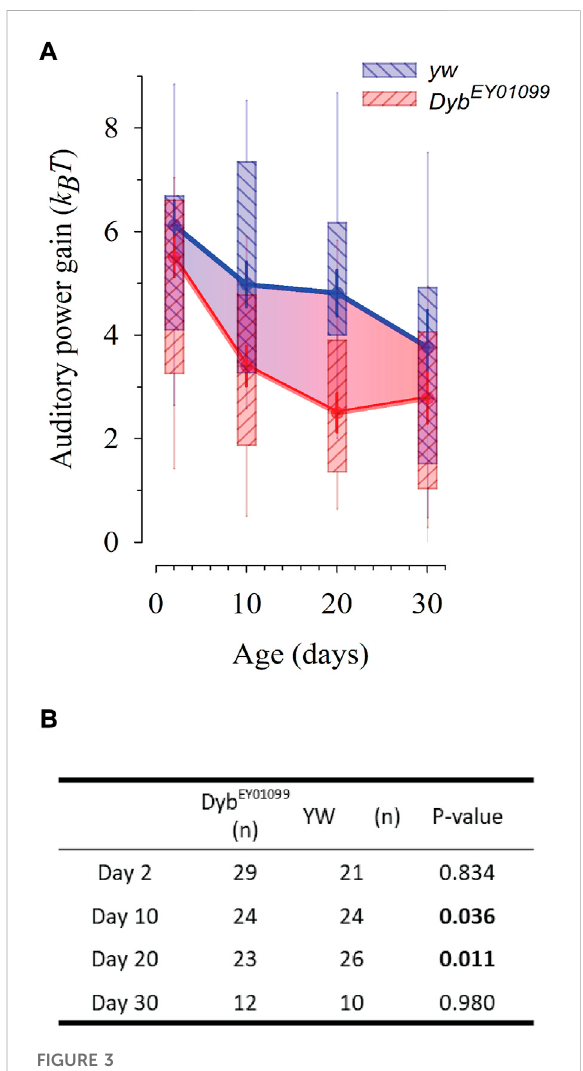
FIGURE 3 Dyb EY01099 mutant fl ies present with progressive, early onset hearing loss. The life course of auditory power gain ( Δ KBT, the fl y ’ s ‘ cochlear ampli fi er ’ ) is affected in Dyb EY01099 . Data presented as median ± SEM. (A) The loss of auditory ampli fi cation starts earlier, and is steeper, in Dyb EY01099 mutants as compared to their yw controls. While at day 2, ampli fi cation in Dyb EY01099 mutants isstatistically identical to that of yw controls ( p = 0.834), it falls signi fi cantly below control levels at day 10 ( p = 0.036) and day 20 ( p = 0.011). At day 30, the slower, yet constant hearing decline of controls has caught up with the accelerated hearing loss seen in Dyb EY01099 , and no more statistical difference is observed ( p = 0.980). The box ends demarcate the 25th and 75th percentiles; fi ne error bars de fi ne the 10th and 90th percentiles. Symbols re fl ect the medians and thick error bars the standard error of the median. (B) Statistical data for auditory power gains in Dyb EY01099 and yw controls across ages. The power reduction seen in middle-aged fl ies is equivalent to a moderate to severe hearing loss condition in humans and suggestive of a disturbed auditory homeostasis. Test: